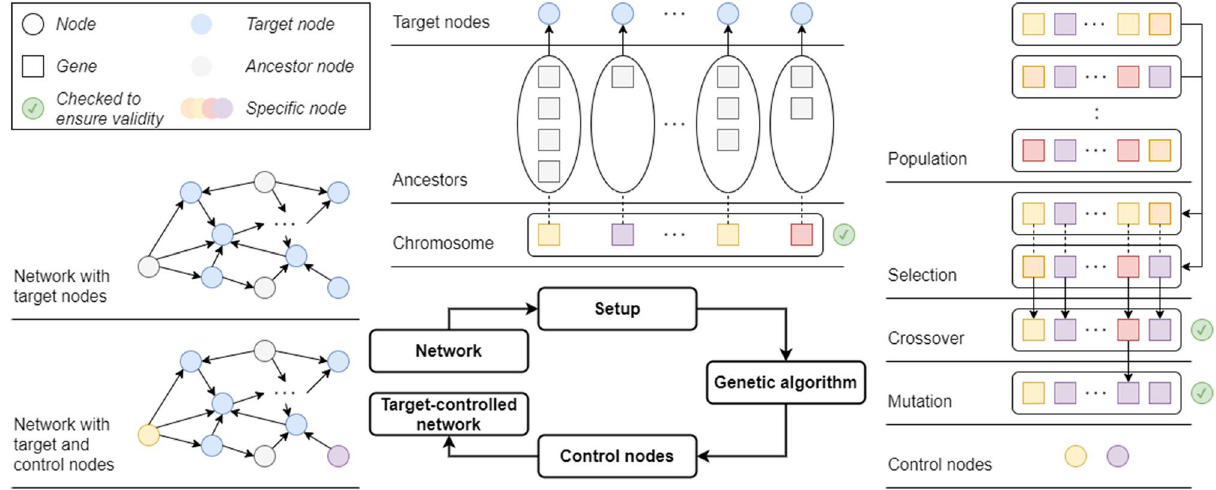
Figure 1. The basic outline of the genetic algorithm, shown in a clockwise manner: the required data, the initial setup and chromosome encoding, the operators of the genetic algorithm, and the chromosome decoding